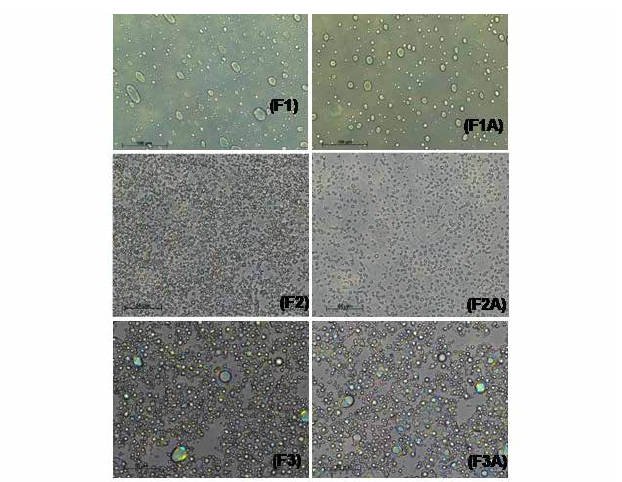
FIGURE 1 – Photomicrographs under polarized light of the formulations ( F1, F1A, F2, F2A, F3 and F3A ).